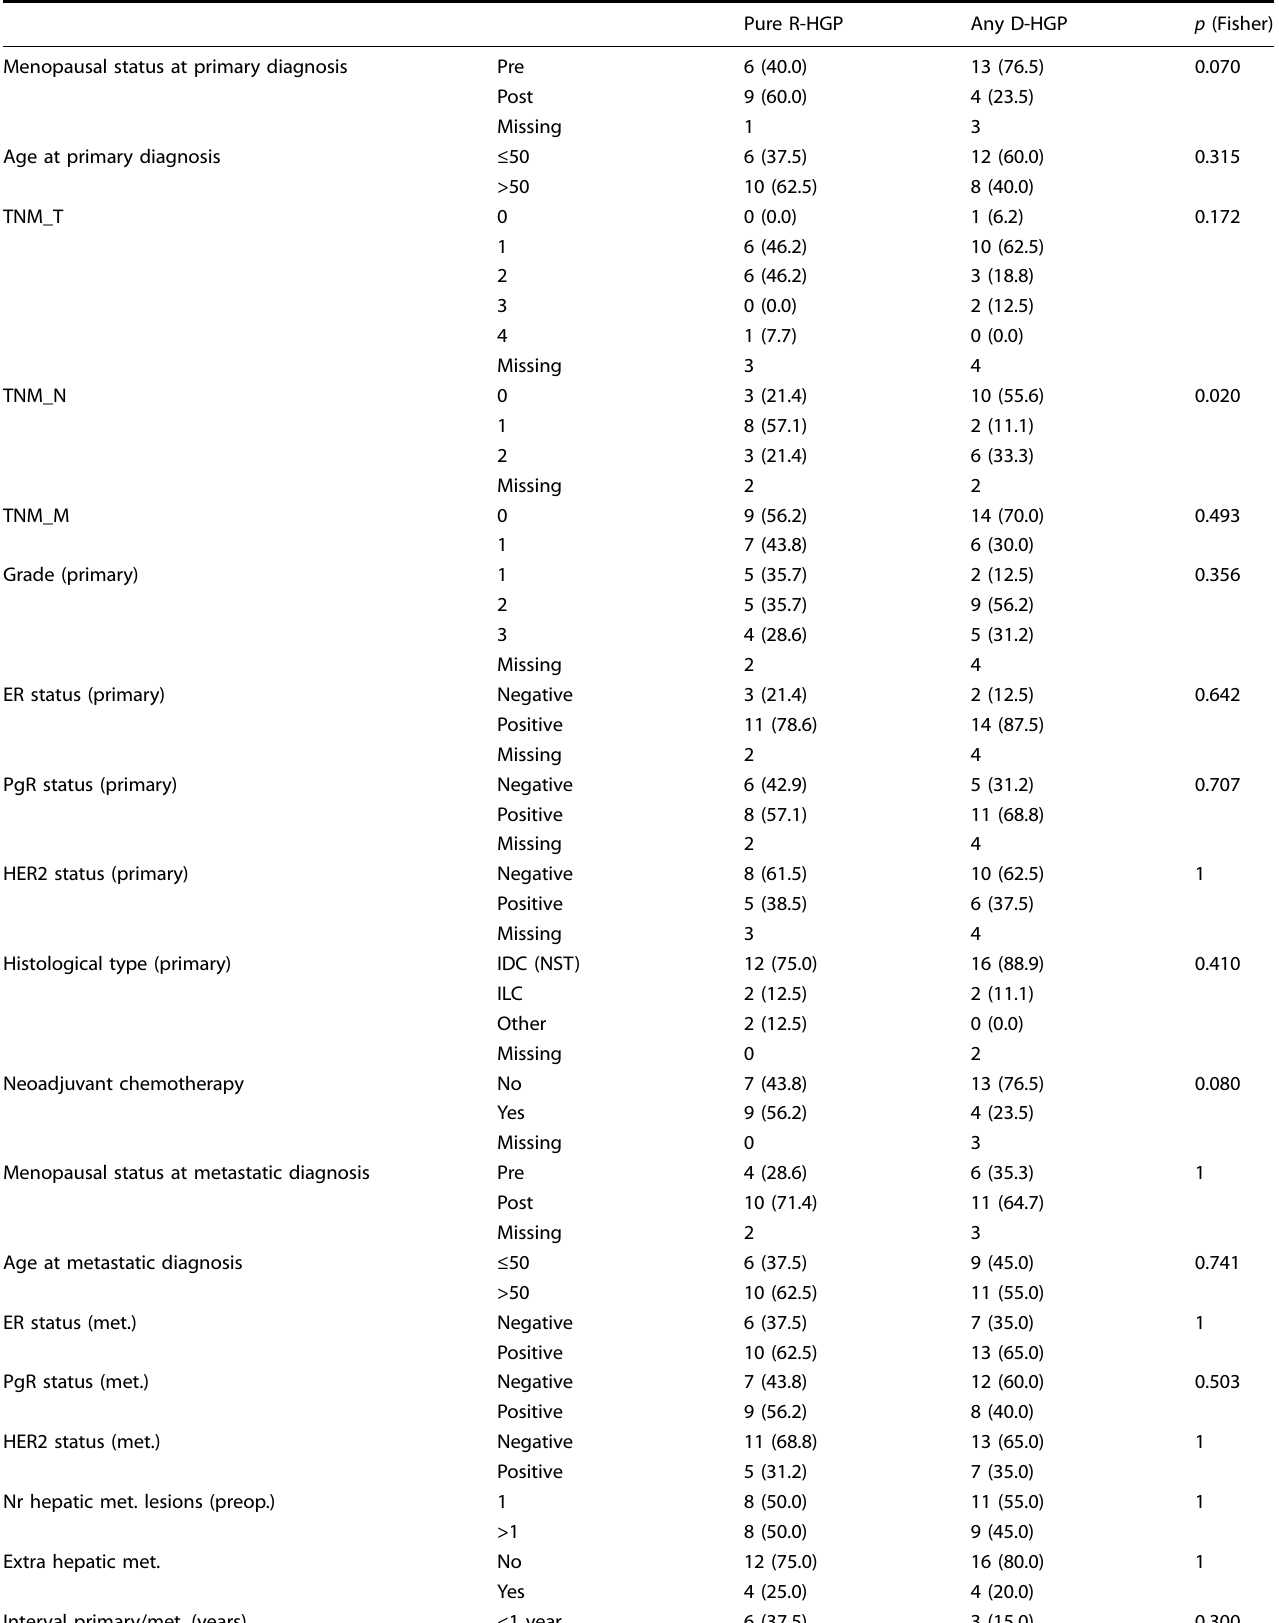
Pure R-HGP Any D-HGP p (Fisher)